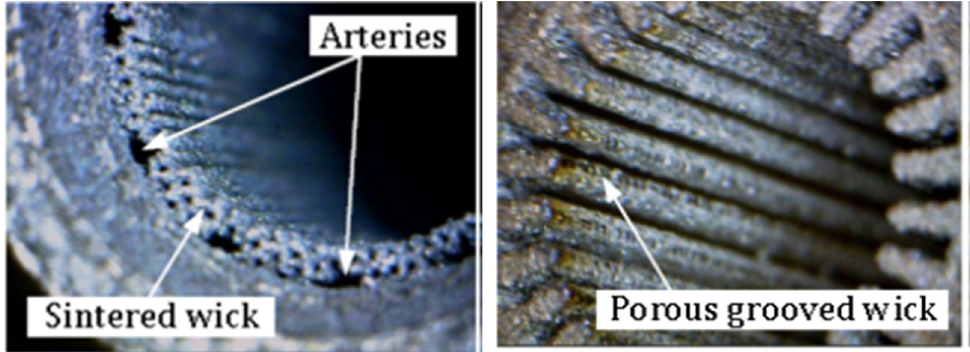
Figure 4. Close-up AM HPs with sintered porous wick structure: arterial wick ( left ); porous grooved wick ( right ) [4,10].